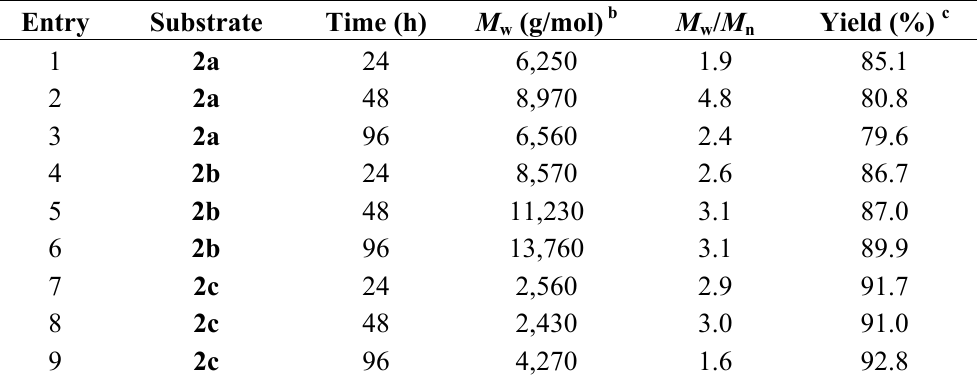
Table 1. Synthesis of polyester by enzyme-catalyzed polycondensation a .